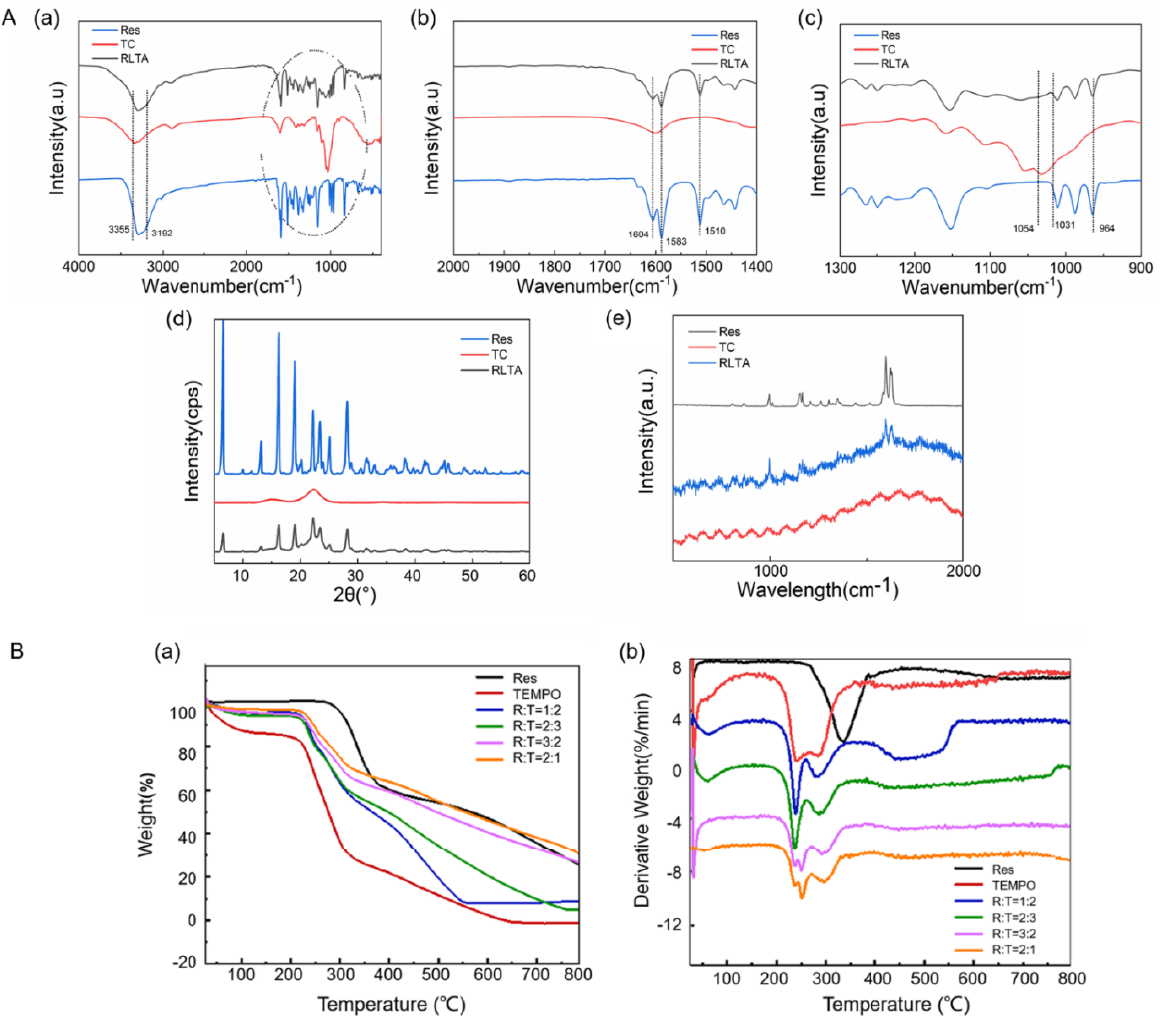
Figure 2. ( A ) Characterization of materials and drugs: ( a – c ) FTIR of Res, TC aerogel and RLTA. ( d ) XRD of Res, TC aerogel and RLTA. ( e ) Raman of Res, TC aerogel and RLTA; ( B ) Thermogravimetric curves of TC aerogel, Res and RLTAs. ( a ) TG of Res, TC aerogel and RLTA; ( b ) DTG of Res, TC aerogel and RLTA.